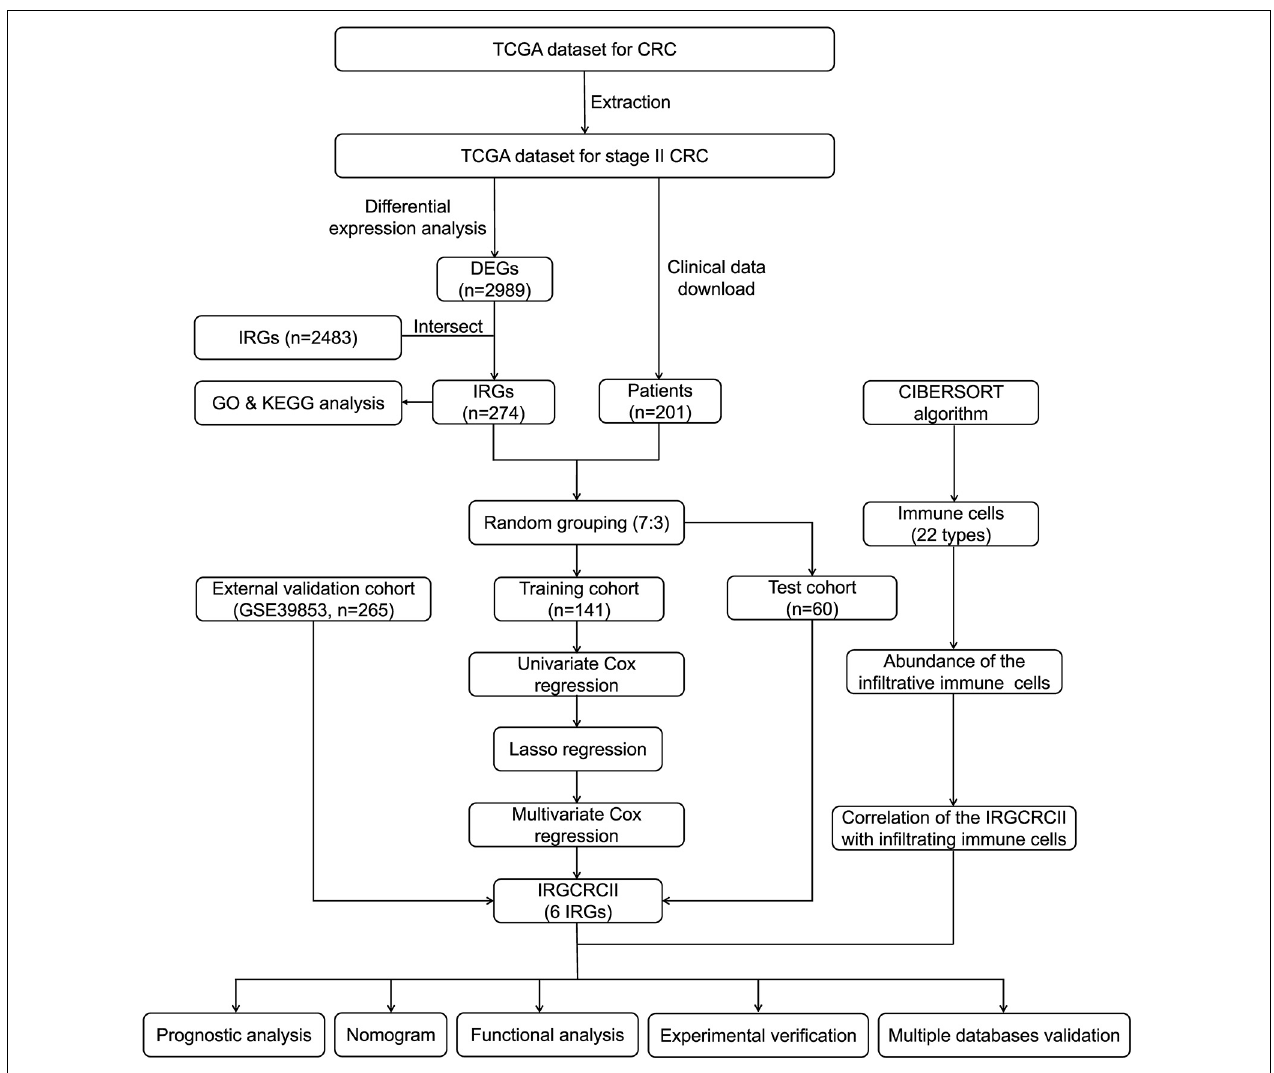
FIGURE 1 | Analysis and design flow chart. CRC, colorectal cancer; DEGs, differentially expressed genes; IRGs, immune-related genes; GO, Gene Ontology; KEGG, Kyoto Encyclopedia of Genes and Genomes; LASSO, the least absolute shrinkage and selection operator method; TCGA, The Cancer Genome